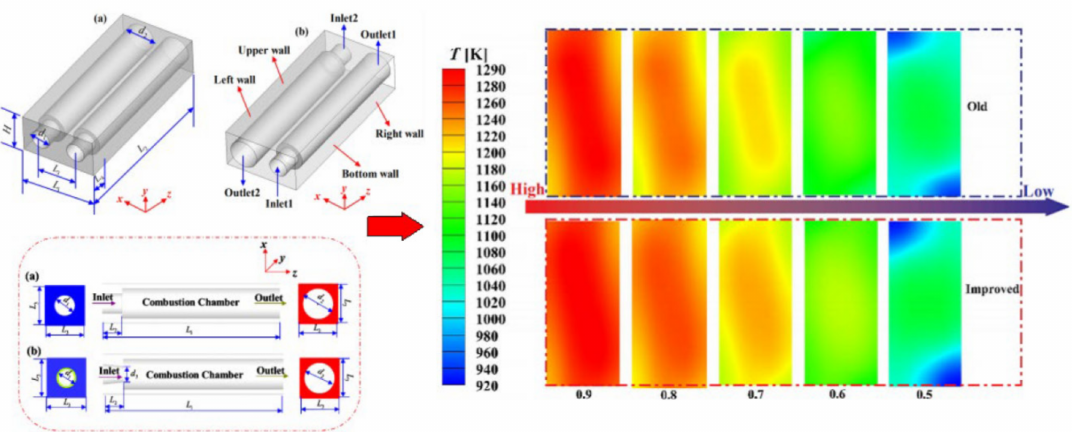
Figure 27. Schematic of two counterflow double-channel micro combustors and temperature